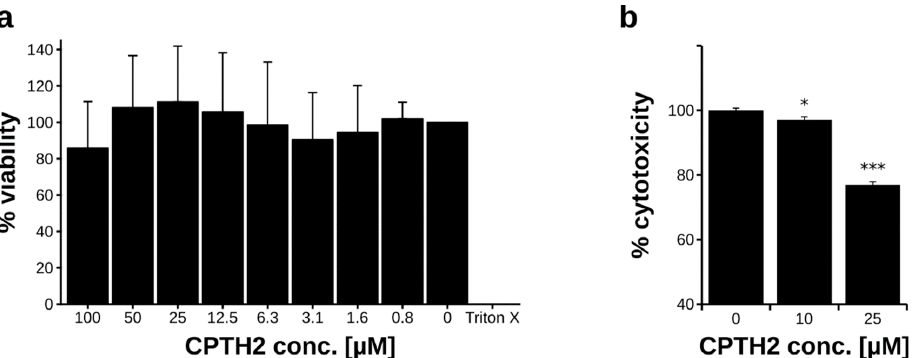
Figure 4. CPTH2 protects macrophages from C. albicans -mediated killing. ( a ) Cytotoxicity of CPTH2 was determined using HEK293 cells. Cells were incubated with the indicated concentrations of CPTH2 for 24 hours, followed by quantification of surviving cells using a XTT assay. ( b ) Murine primary macrophages were incubated with C. albicans cells and CPTH2 as indicated, and macrophage survival was determined after 18 hours interaction using a lactate dehydrogenase (LDH) release assay. Note: * p <0.05, *** p <0.001. (a,b) Data shown are mean + sd of three biological replicates. Next, we incubated primary murine macrophages with fungal cells in the presence or absence of different concentrations of CPTH2. After 18 h incubation, lysis of macrophages was determined by measuring lactate dehydrogenase release into the medium. Strikingly, addition of 10 µM CPTH2 slightly but already significantly reduced macrophage lysis upon interaction with C. albicans (Figure 4b). Moreover, increasing the CPTH2 concentration to 25 µM strongly reduced lysis of the immune cells. Thus, our data indicate that CPTH2 can be used to protect host cells from C. albicans -mediated death. 4. Discussion In this work, we discovered that the Gcn5 HAT inhibitor CPTH2 can potently inhibit growth of pathogenic fungi and even has fungicidal activity. We have shown that CPTH2 has selective antifungal activity on CTG clade Candida species, including Candida albicans , one of the most prevalent human fungal pathogens. Furthermore, CPTH2 can protect primary macrophages from Candida -mediated death, demonstrating its antifungal activity. Interestingly, the inhibitory effect of CPTH2 appears to be independent of direct Gcn5 inhibition, since deletion of GCN5 increases the sensitivity to this drug. Furthermore, histone H3 acetylation is unchanged upon treatment with inhibitory concentrations of CPTH2. These data are in line with previous reports showing that CPTH2 does not only inhibit Gcn5, but also has other targets as well [19,22–24]. In S. cerevisiae deletion of GCN5 also increases the susceptibility to CPTH2, albeit at much higher concentrations compared to CTG clade Candida species [19,22]. Furthermore, in mammalian systems CPTH2 or its derivatives have been shown to also inhibit the HATs p300 and NAT10 [23,24]. Based on its conserved target site H3K56 and on structural similarities, the fungal-specific Rtt109 HAT has been identified as an orthologue of p300 [25]. In addition, a NAT10 orthologue is also present in Candida species [26]. Thus, Rtt109 and Nat10 are additional target candidates for CPTH2, which require further investigation. Notably, all aforementioned HATs are able to acetylate histone H3 [16,24]. Interestingly, the members of the CTG clade, in addition to 2 copies of the canonical histone H3, encode for an additional copy of histone H3, which differs in 3 amino acids [26]. This histone variant is not found in non-CTG clade species, such as S. cerevisiae or Candida glabrata . Thus, it is tempting to speculate that the CTG clade specificity of CPTH2 could be connected to the presence of this additional H3 variant. In S. cerevisiae , depletion of the HDAC Hda1 can rescue growth defects of a gcn5 Δ mutant, as well as its increased sensitivity to CPTH2 [22]. Thus, Hda1-related histone modifications might also